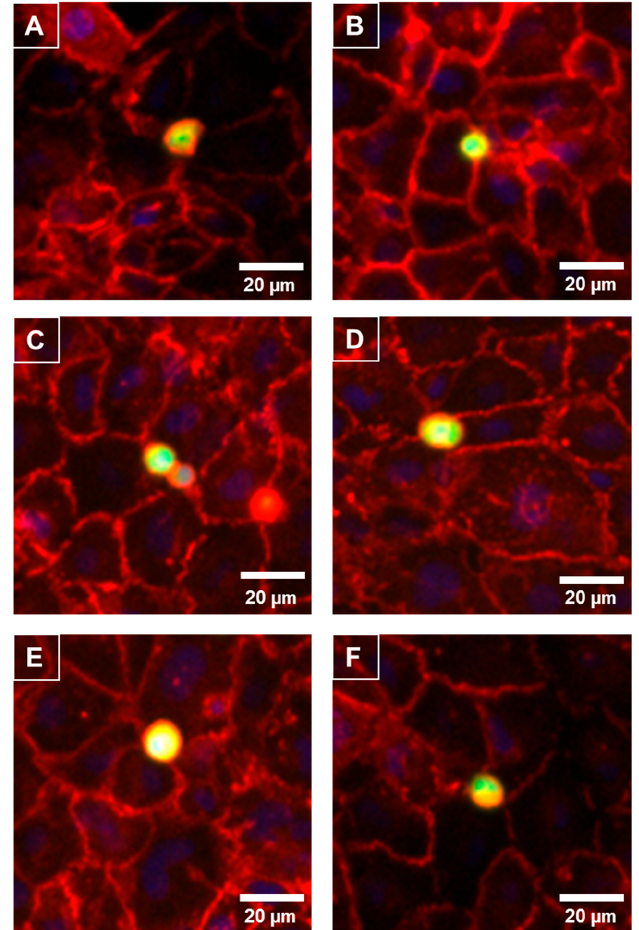
Figure 6. Preferential adhesion of melanoma cells (NZM7) to hCMVEC endothelial junctions. NZM7 cells were live-stained with CMFDA (green) and applied to the apical face of hCMVECs. Cells were co-cultured for 30 min, fixed and endothelial junctions were visualized with anti- α -catenin (red). Nuclei were visualized using DAPI. ( A ) – ( F ) Multiple examples of a melanoma cell (green/yellow) localising at endothelial junctions (red). Images ( A ) and ( D ) are good examples of the melanoma cell residing at a multi-junctional location (corner of several endothelial cells). ( B ) shows a small melanoma cells at the junction of a large clearly visible endothelial cell. ( C ) is an example of multiple melanoma cells adhered at the same junctional positon. ( E ) exemplifies a large melanoma cell positioned at multiple endothelial junctions and ( F ) shows a melanoma cells on the junctional border of four neighbouring endothelial cells. Images shown are representative of two independent experiments. Scale bar is 20 µm.